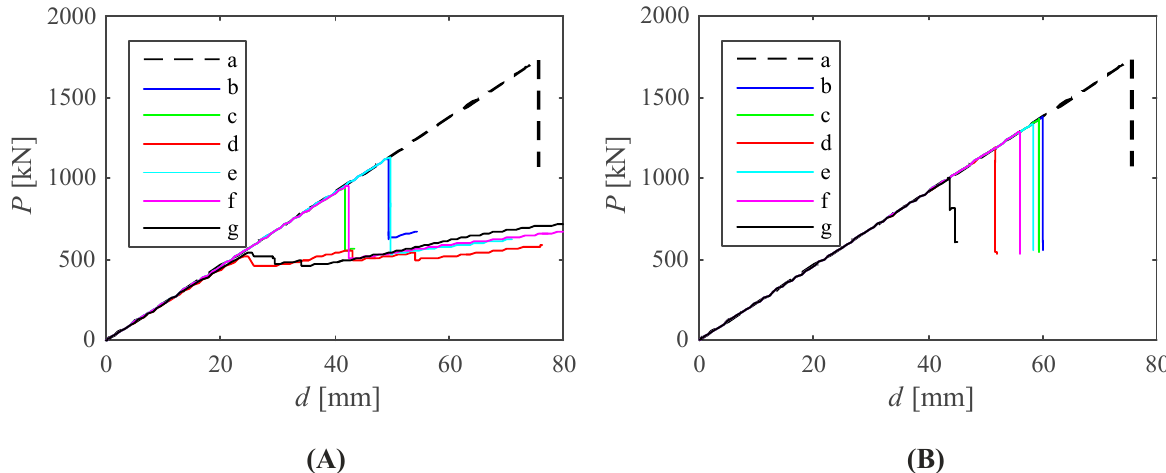
Figure 7. Evolution of total vertical reactions and average vertical displacement of columns top edges obtained from geometrically non-linear analyses of the silo segment with initial imperfections in the form of: ( A ) buckling modes: (a) B0, (b) B1_2 mm, (c) B1_5 mm, (d) B1_20 mm, (e) B2_2 mm, (f) B2_5 mm, (g) B2_20 mm; ( B ) vibration modes: (a) B0, (b) F1_2 mm, (c) F1_5 mm, (d) F1_20 mm, (e) F2_2 mm, (f) F2_5 mm, (g) F2_20 mm.